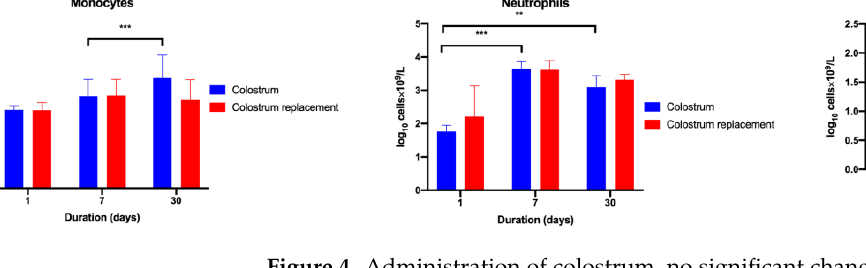
Figure 4. Administration of colostrum, no significant changes were observed in the calves ’ blood monocyte, neutrophil and basophil populations. The experimental animals ( n = 5 in each group) received colostrum or an artificial colostrum replacer for the first 6 h after birth. On days 1, 7